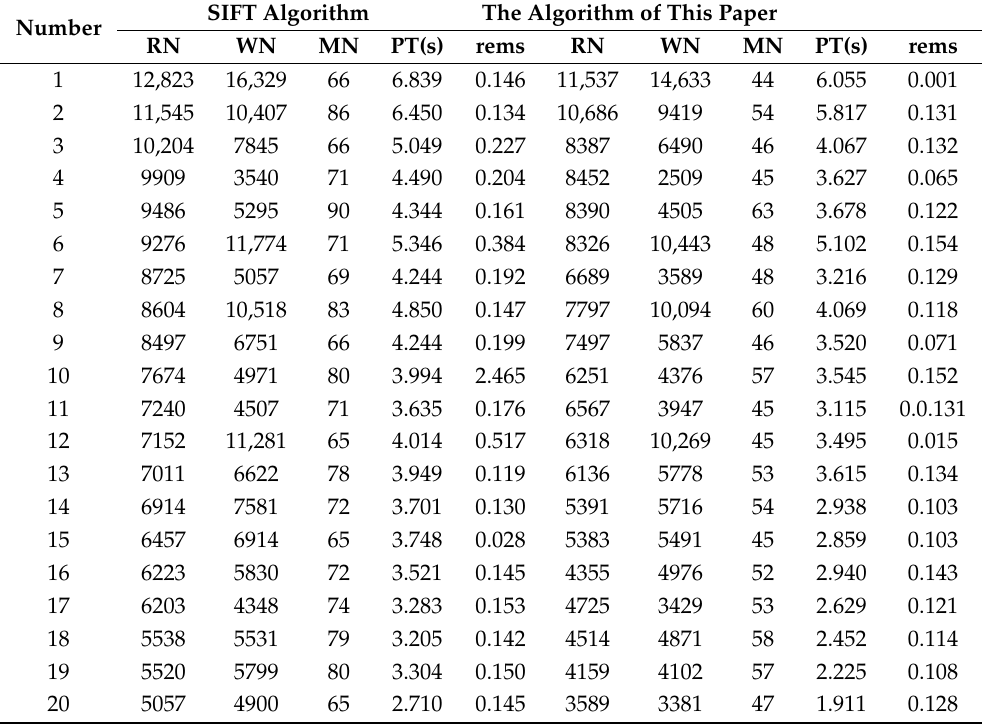
Figure 7. Comparison of the kitti dataset’s specific experimental data in four categories. ( a ) the number of feature points of the reference image; ( b ) the number of feature points of the images to be compared; ( c ) matching time; ( d ) Rems errors. Table 1. Comparison of the results of Kitti